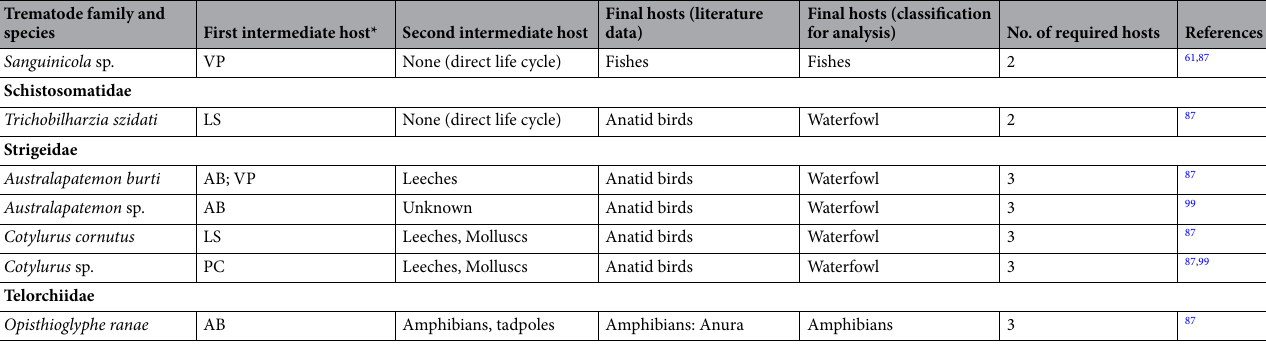
Table 3. Summary of the recorded trematode species in all collected mollusc species and their second intermediate and final host groups. *BT: Bithynia tentaculata ; LS: Lymnaea stagnalis ; AB: Ampullaceana balthica ; SP: Stagnicola palustris ; PA: Physa acuta ; AV: Anisus vortex ; PC: Planorbarius corneus ; PP: Planorbis planorbis ; VP: Valvata piscinalis . a Alaria spp. develop in a three-host life cycle with an interjectional mesocercarial stage between the cercarial and the metacercarial stage. This life cycle can be extended by paratenic